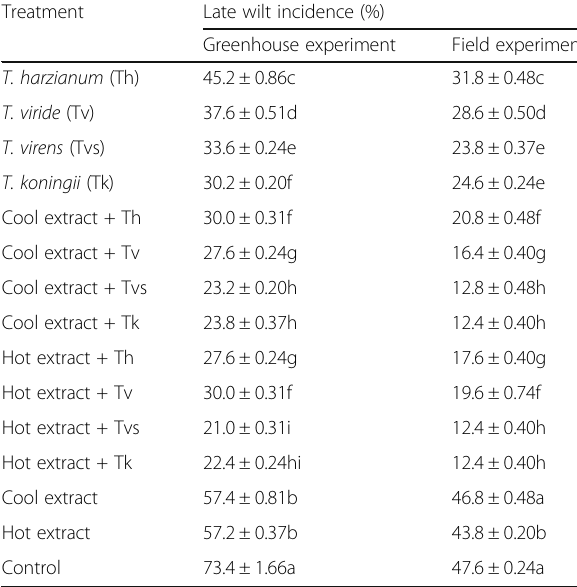
Table 4 Effect of Trichoderma spp. alone or in combination with Chlorella vulgaris extract on the incidence of late wilt of maize grown under greenhouse and field conditions Treatment Late wilt incidence